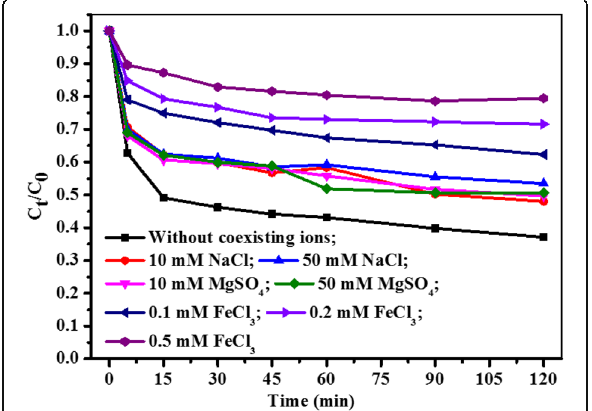
Fig. 8 Effect of coexisting cations and ionic strength on the adsorption of MB on Fe 3 O 4 /PCC MNPs. As shown as Fig. 8, the blank line represent the adsorption of MB without any coexisting ions, the red line reperesent the effect on MB adsorption with 10 mM NaCl, the blue line reperesent the effect on MB adsorption with 50 mM NaCl, the magenta line reperesent the effect on MB adsorption with 10 mM MgSO 4 , the olive line reperesent the effect on MB adsorption with 50 mM MgSO 4 , the navy line reperesent the effect on MB adsorption with 0.1 mM FeCl 3 , the violet line reperesent the effect on MB adsorption with 0.2 mM FeCl 3 , the purple line